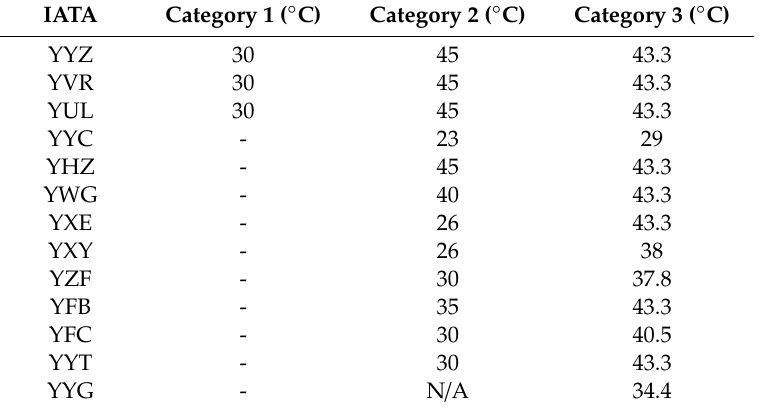
Table 3. Temperature thresholds used to estimate weight restriction days for studied airfields. “N / A” means the aircraft cannot takeo ff at MTOW at any temperature because of a relatively short